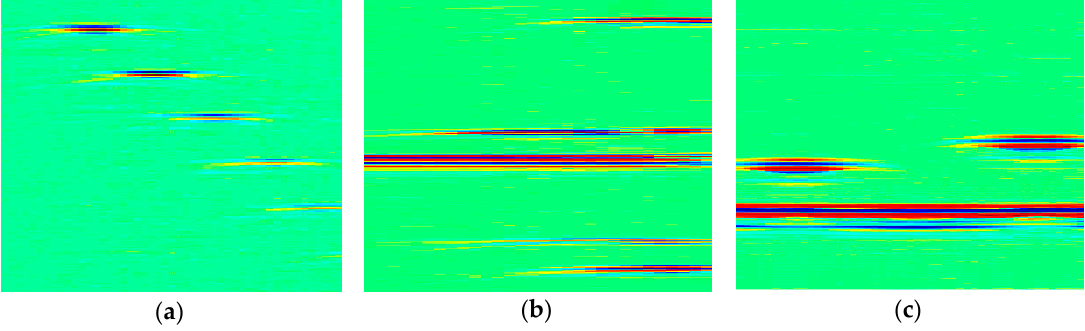
Figure 22. The recovery results of 20 MHz SR experimental image in frequency domain, ( a ) through- holes, PSNR = 42.91 dB; ( b ) EDM notches, PSNR = 41.50 dB; ( c ) flat-bottom holes, PSNR = 41.68 dB.